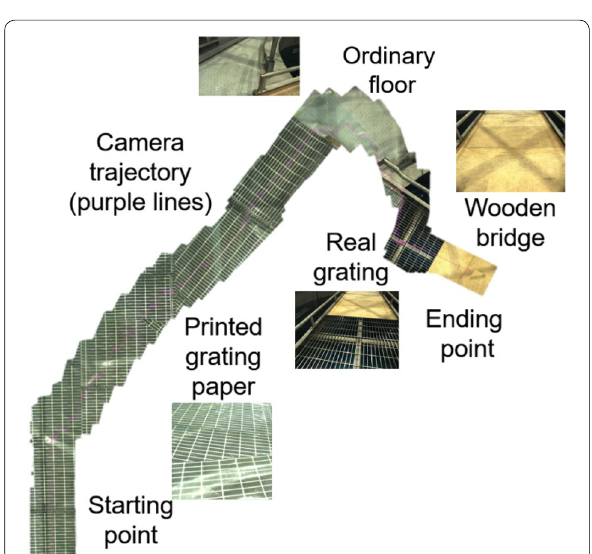
Fig. 12 One of the maps generated by the visual odometry method under the simulated